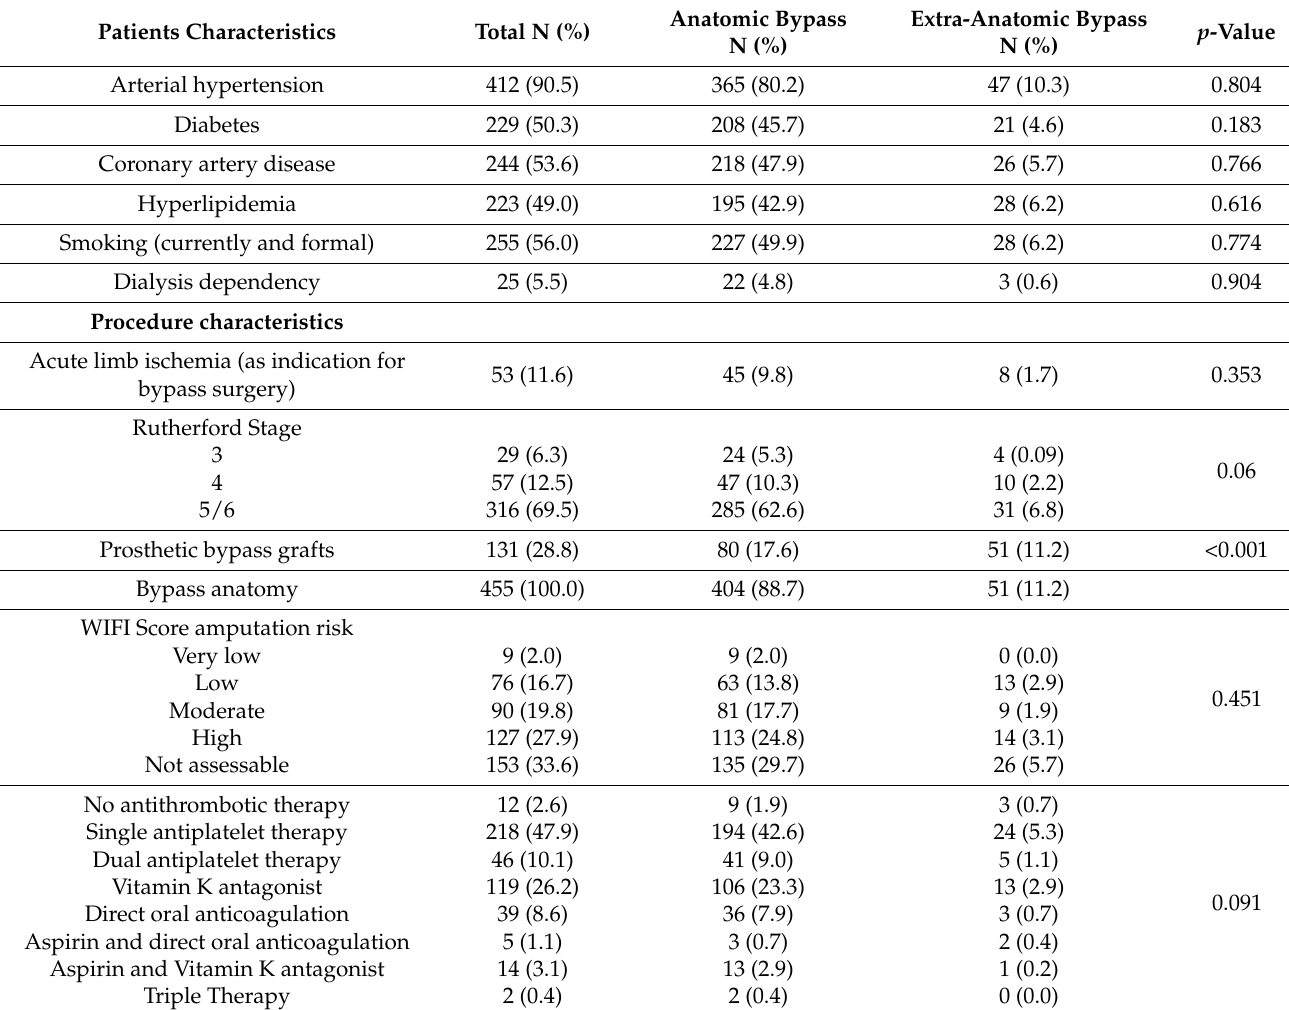
Table 1. Patients and periprocedural characteristics and comparison of the distribution between the anatomic and extra-anatomic bypass